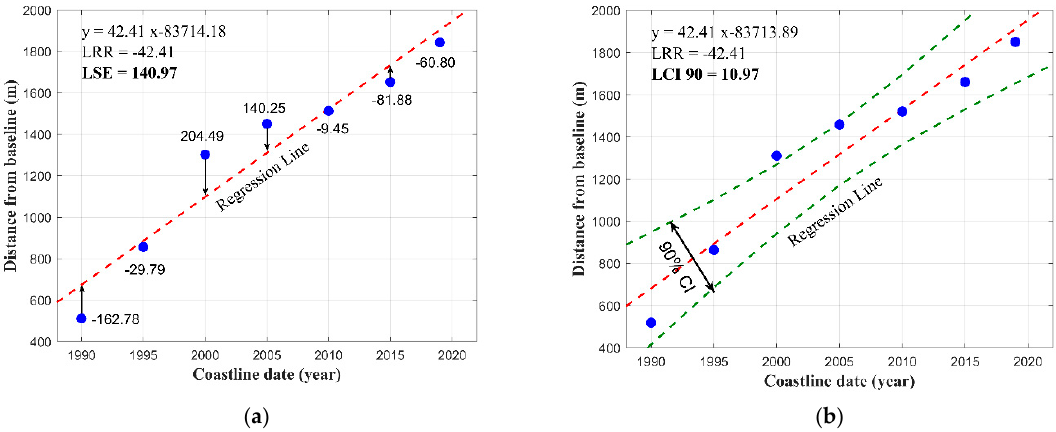
Figure 10. Example of DSAS supplemental statistics for Transect ID 509, with blue dots as the measurement point in each year and their distance from the baseline to the intersection point; red dash presents the best-fit slope (regression line of transect); LRR is computed by the sum of squared residuals. The slope of the equation describing the line is the rate. ( a ) the LSE values and ( b ) LCI90 points.